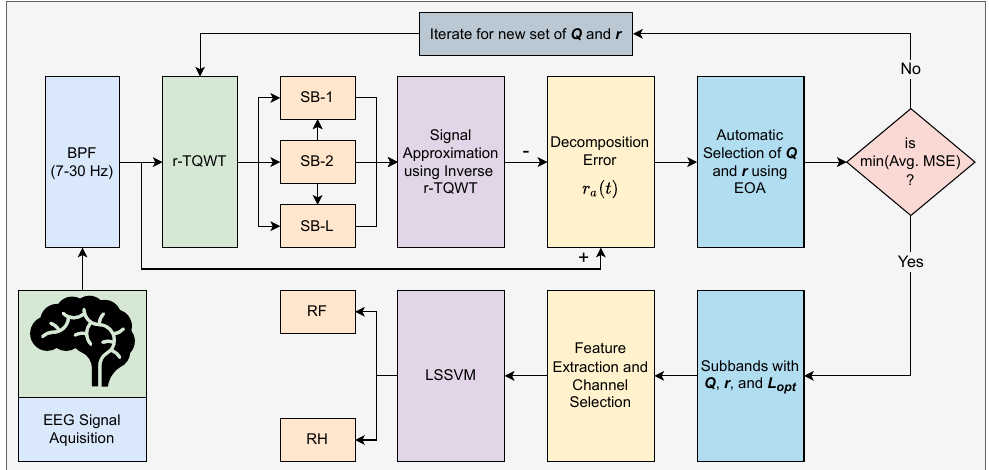
Figure 1. Workflow of proposed robust TQWT framework with channel selection.